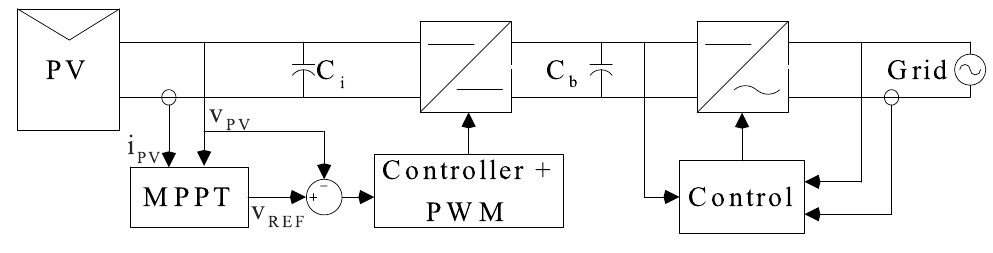
Figure 1. Double stage-grid connected PV